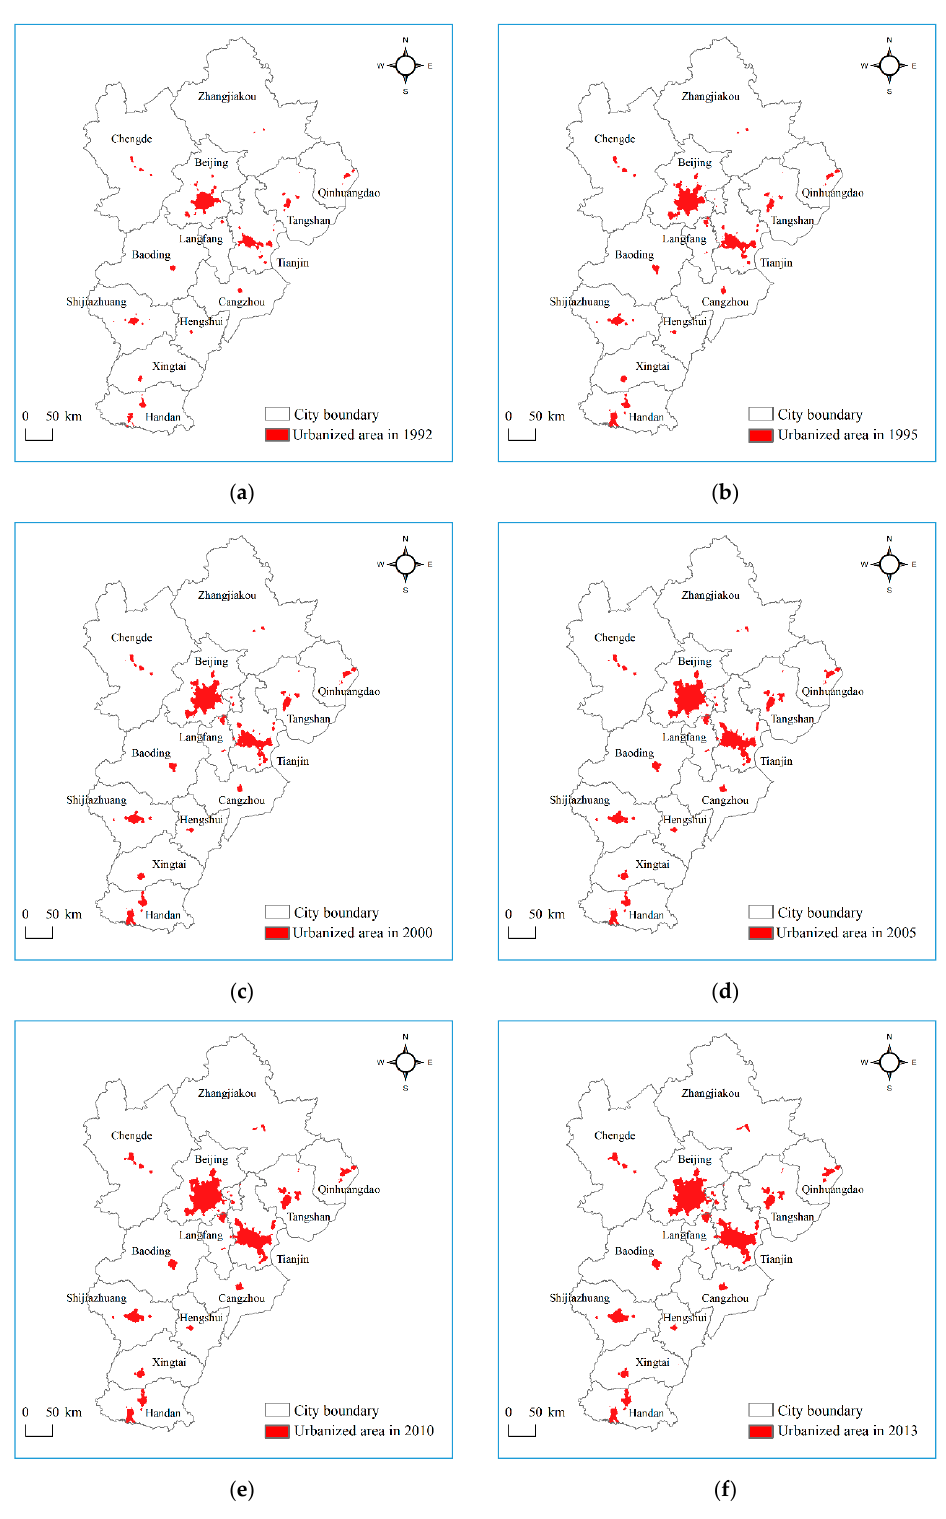
Figure 7. Urban growth in Beijing–Tianjin–Hebei region reflected by night light data (1992–2013). ( a ) 1992; ( b ) 1995; ( c ) 2000; ( d ) 2005; ( e ) 2010; ( f ) 2013. Note: The changing process of total quantity of nighttime lights (NTL) reflects urban growth. Using time series of night light data, we can make power spectral analysis and estimate the self-affine record dimension for temporal signals. A set of temporal signals reflect spatial signals from cross-sectional angle of